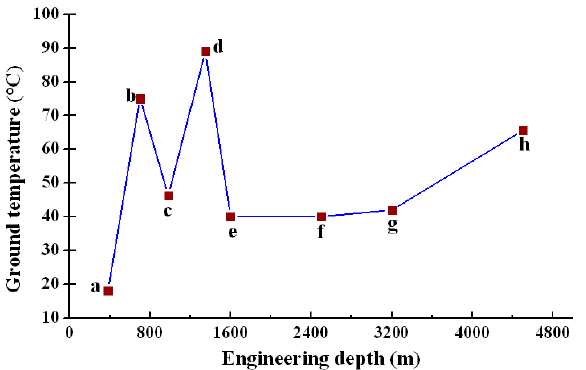
Figure 1. Temperature distribution of tunnels and mines with different depths. In Figure 1: a—Albert tunnel in Austria; b—Anfang highway tunnel in Japan; c— Sanhejian coal mine in China; d—Sangzhuling tunnel in China; e—Qinling tunnel of Xikang railway in China; f—Franco-Yibulangfeng highway tunnel; g—Kolar gold mine in India; h—Mponig gold mine in South Africa.